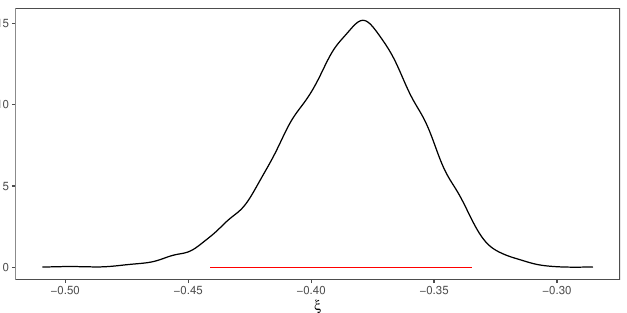
Figure 6. Estimated posterior distribution density function for the shape parameter. The red horizontal line shows the 0.025 to 0.975